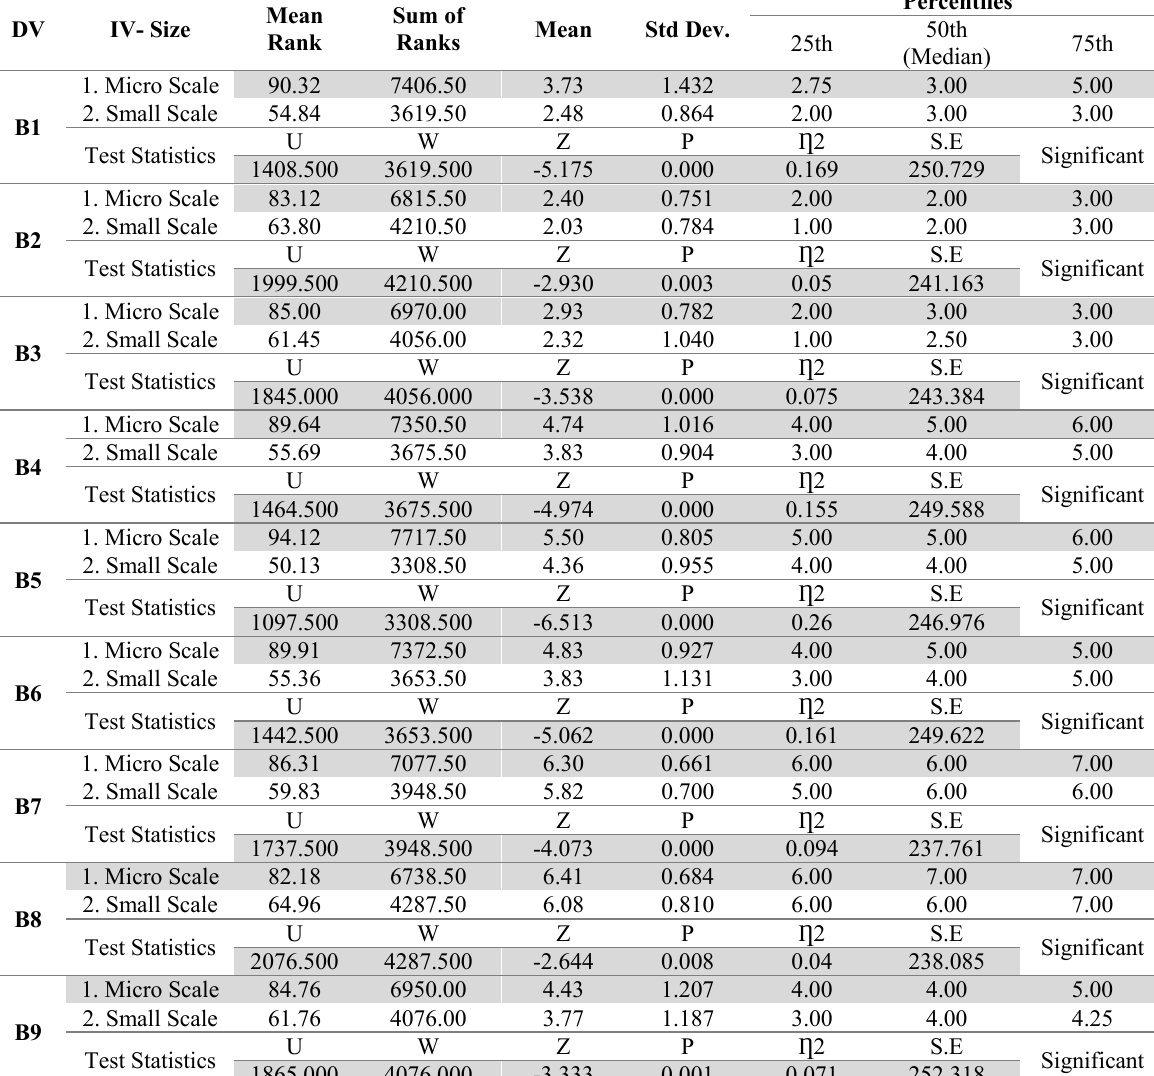
Wilcox-Mann Whitney Test Statistics with effect size and descriptive statistics– Level of concern to- wards the power system reliability and quality issues based on the size of the